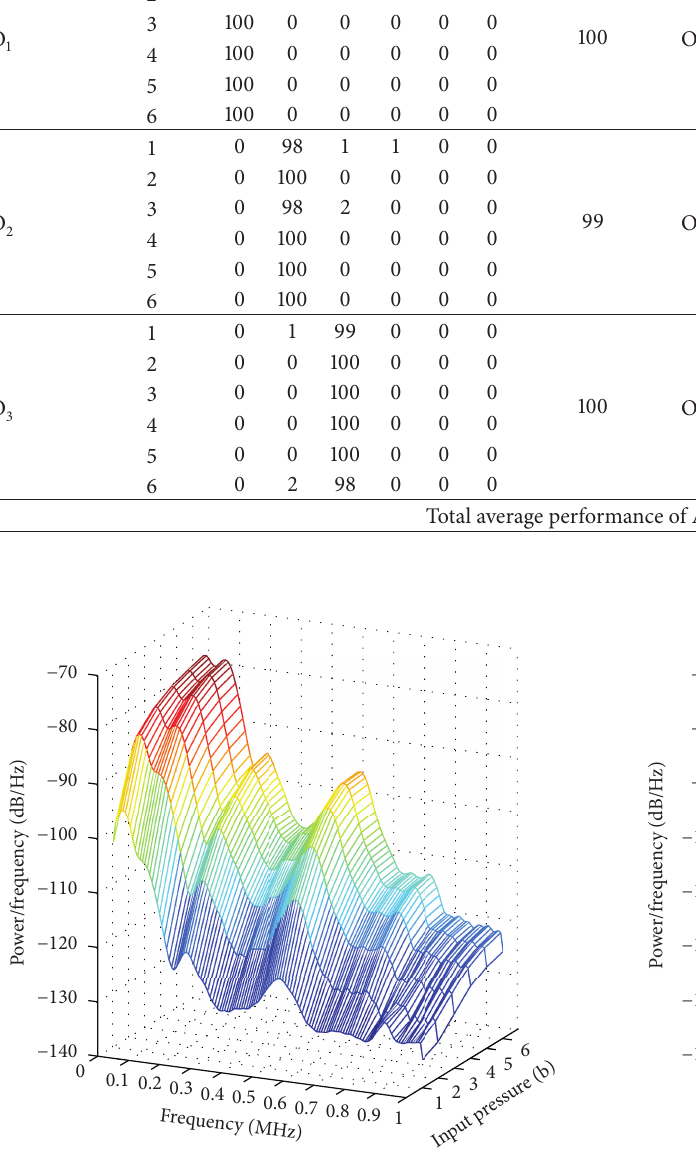
Figure 13: Power spectral density of raw AE signal due to VL through notched exhaust valve in cylinder